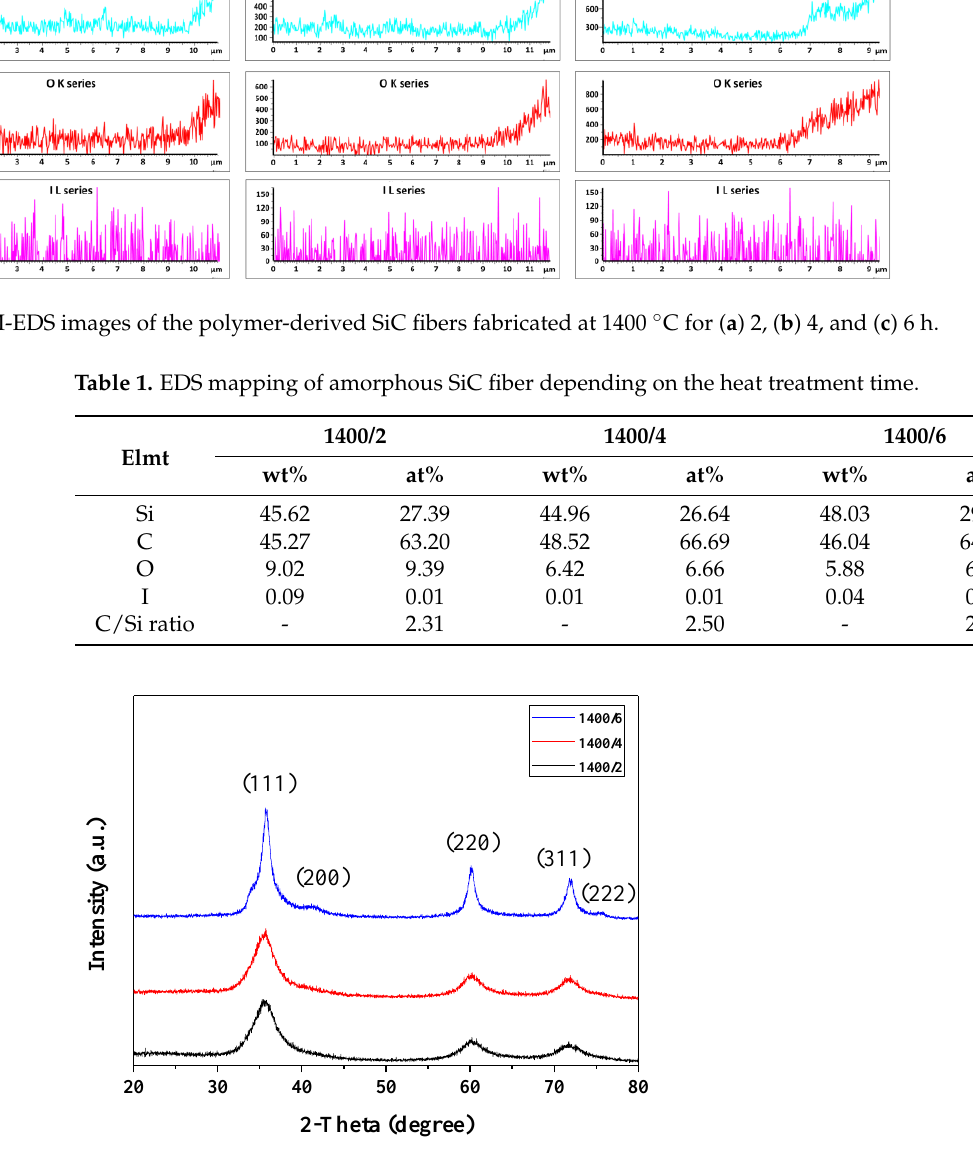
Figure 4. X-ray diffraction patterns of the polymer-derived SiC fiber with different heat treatment times.